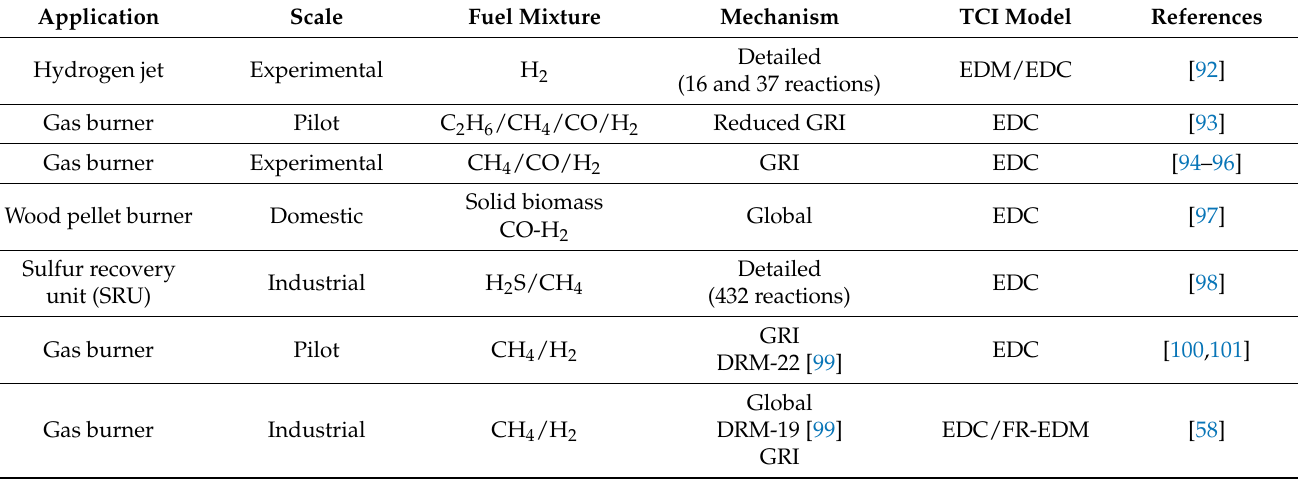
Table A2. Summary of utilized TCI models for different reactive flow modelling at different